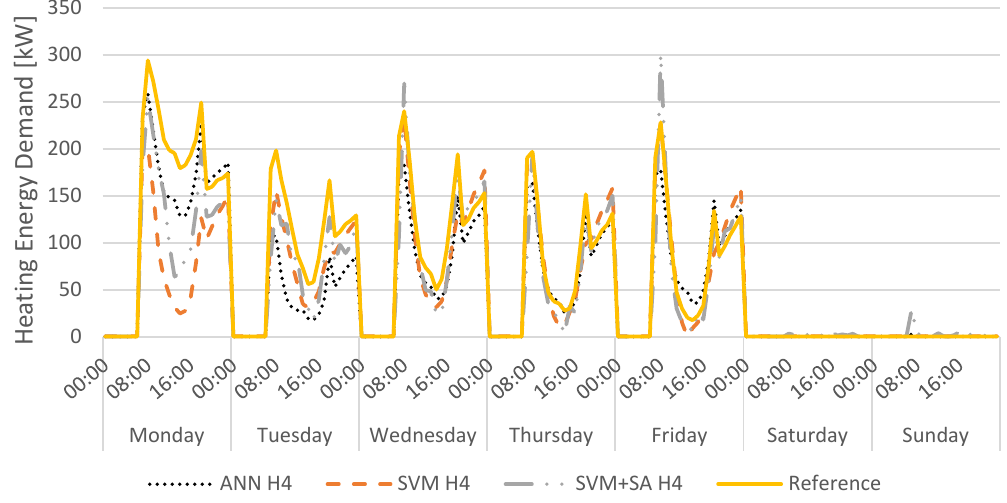
Figure 23. Cooling energy demand load profile for the best performing models, for a full week, from the test subset.